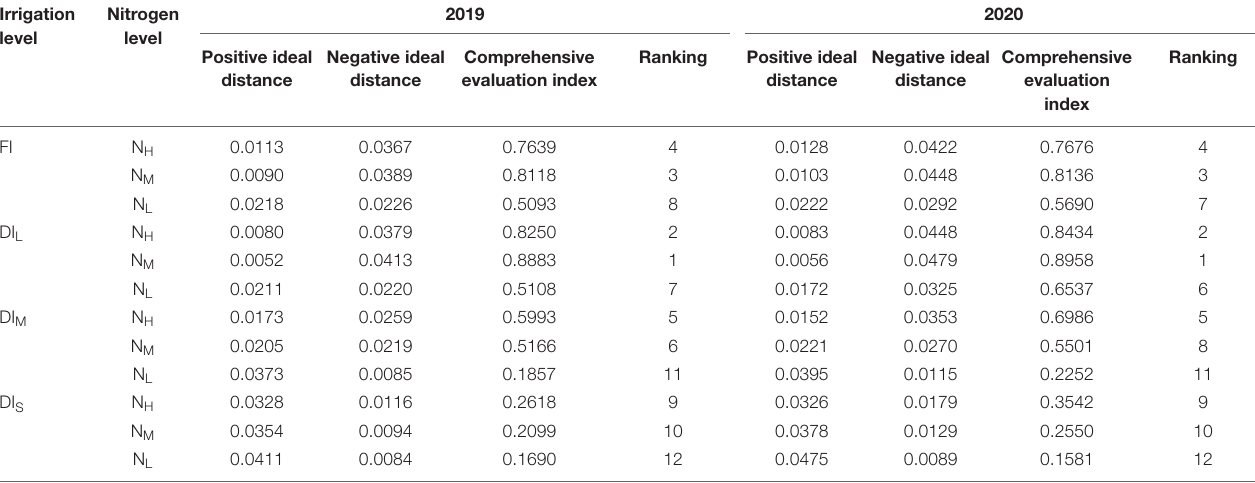
TABLE 5 | Comprehensive evaluation index on yield, quality, and water-nitrogen use efficiency of mountain apple under water and nitrogen coupling by TOPSIS method.